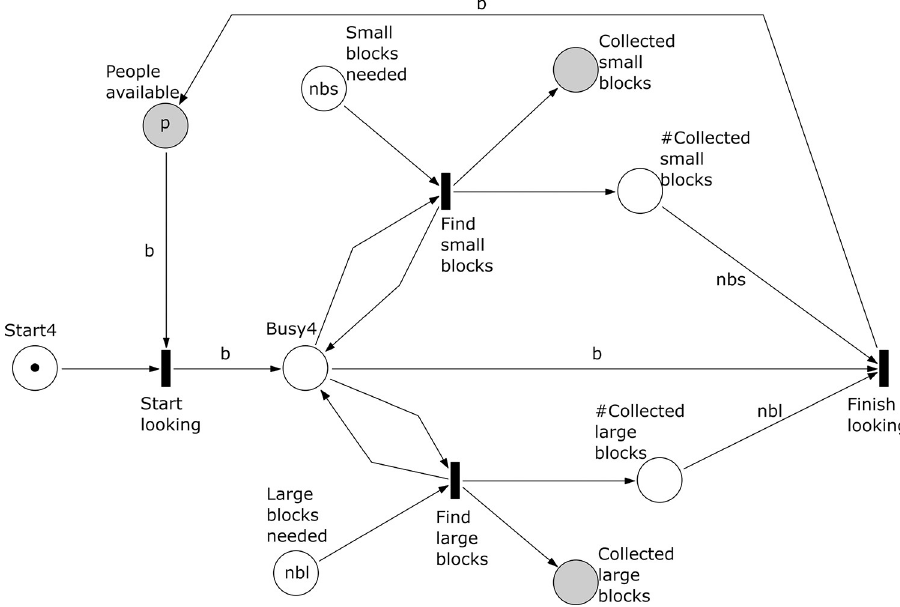
Fig 6. Subprocess 4 Collect Small and Large Calcrete Blocks of the A . coranica